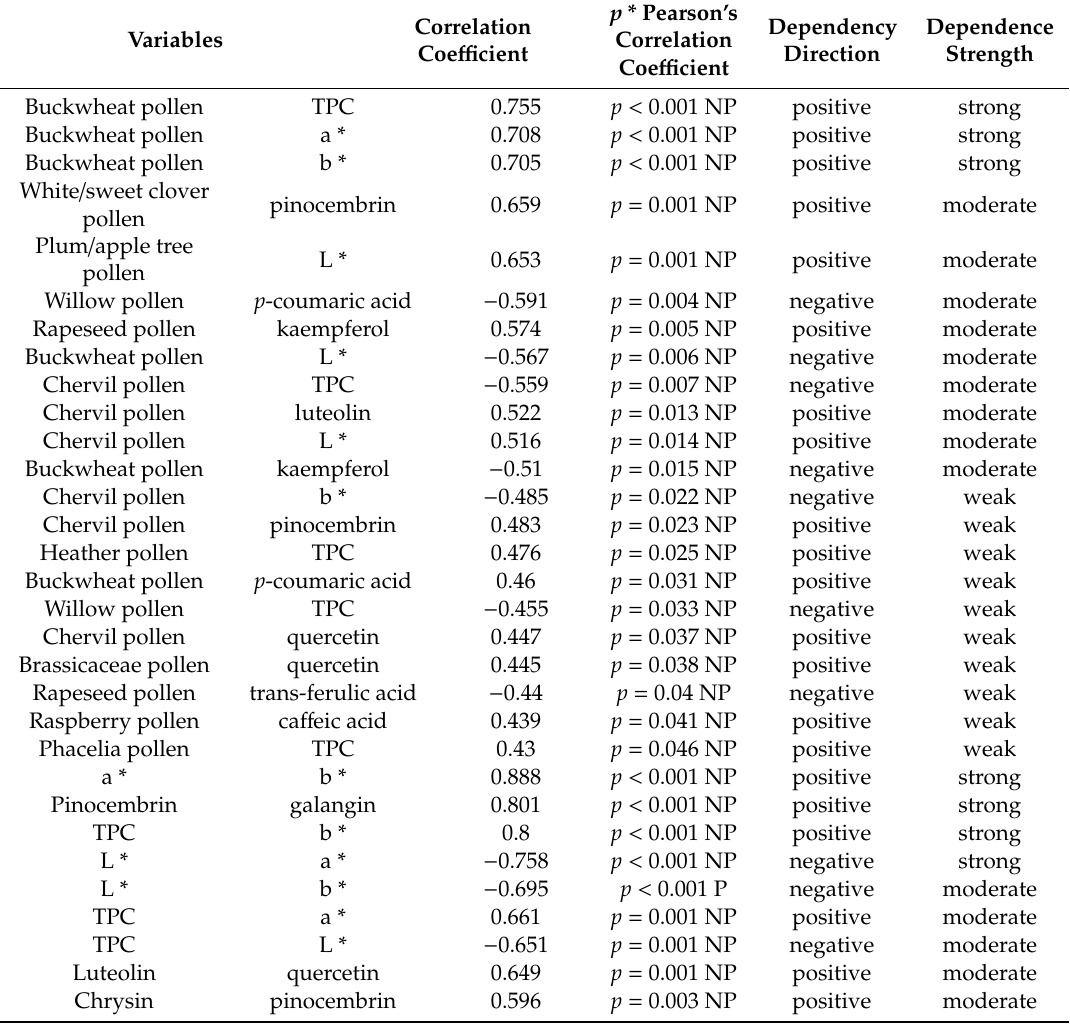
Table 4. Correlations between the parameters